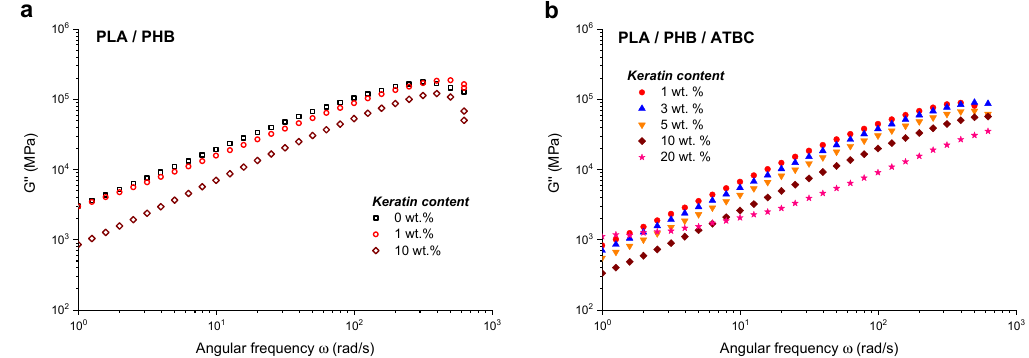
Figure 6. Dependencies of loss modulus G ″ vs. frequency for ( a ) neat PLA/PHB blend without keratin and with 1 wt % and 10 wt % of keratin loading and ( b ) PLA/PHB/ATBC blend with 1 wt %, 3 wt %, 5 wt %, 10 wt % and 20 wt % of keratin loading.